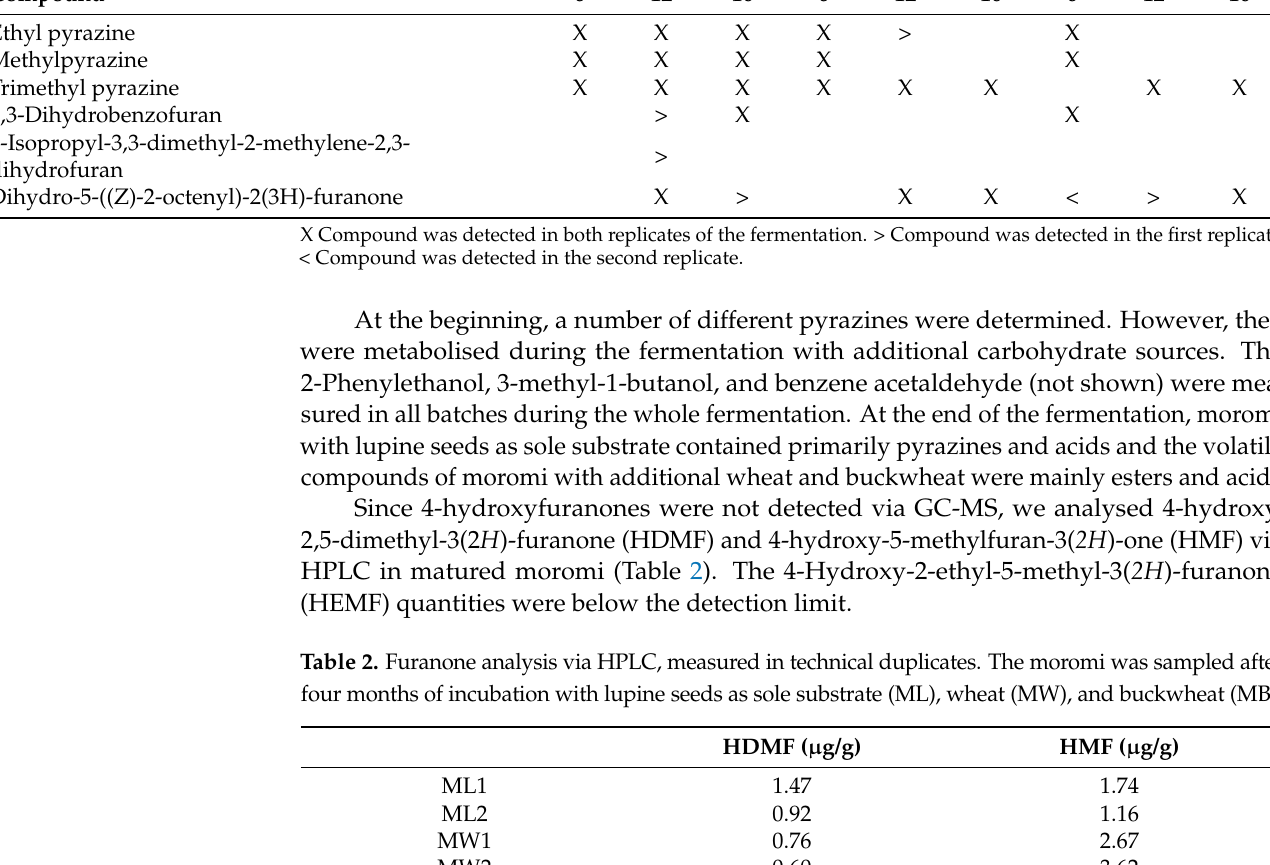
Moromi with Lupine Seeds